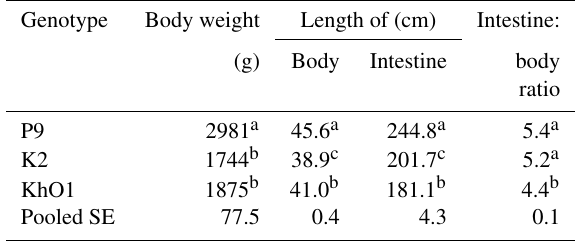
Table 2. Length of intestine segments in spent ducks.